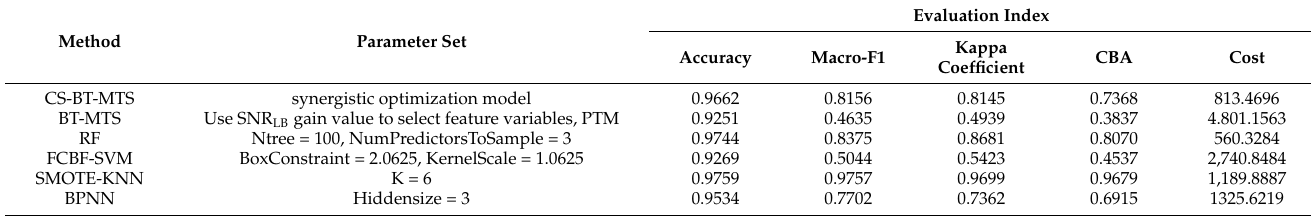
Figure 7. The DRR of MTS classifiers of the Page-blocks data set. The Page-blocks data set comparison results of the six methods are presented in Table 17, and the feature selection result of FCBF-SVM is x 4 , x 8 . Table 17. Comparison of the classification results of the Page-blocks data set.